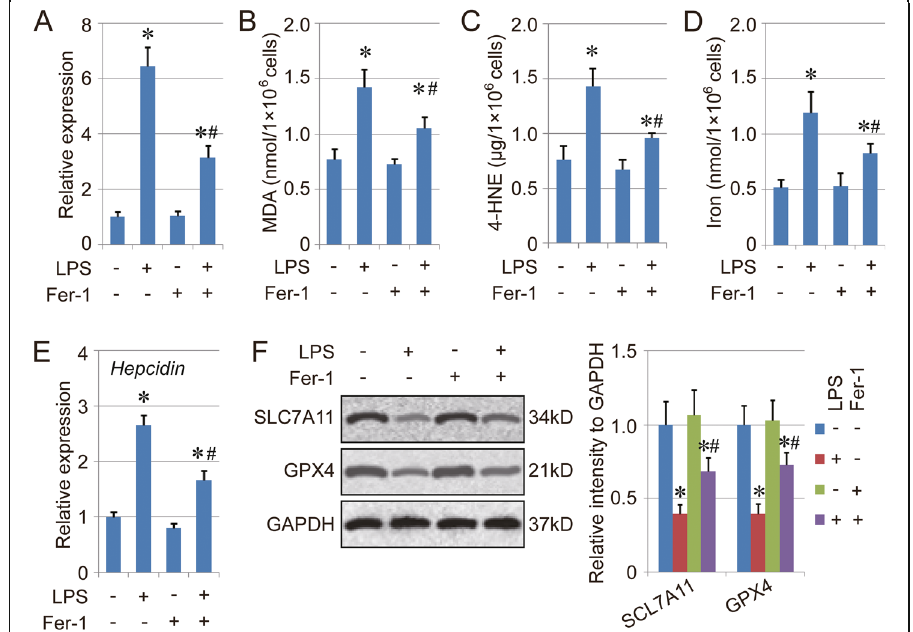
Fig. 6 Fer-1 alleviates LPS-induced ALI through regulating ferroptosis. a . The qPCR analysis of the expression of Ptgs2 in each group. b - d . Levels of MDA (B), 4-HNE (C) and total iron (D) in the lung tissues of different groups. e . mRNA expression of HEPCIDIN . f . Protein levels of SLC7A11 and GPX4 in the lung tissues of different groups. Results are expressed as means±SEM ( n = 4). *: p < 0.05 compared with the control group. #: p < 0.05 compared with the LPS